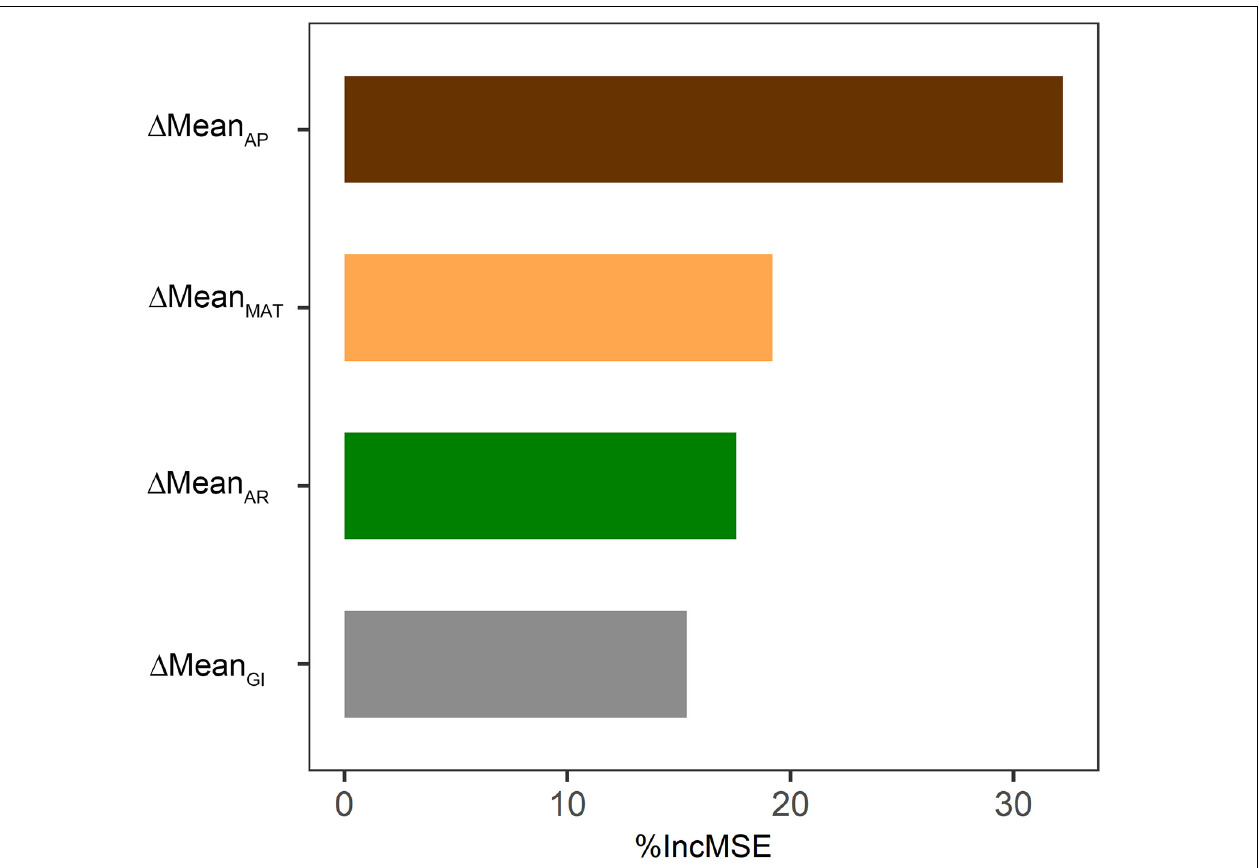
FIGURE 8 | Relative contribution of the differences in means of the four variables ( (cid:49) Mean MAT , (cid:49) Mean AP , (cid:49) Mean AR , and (cid:49) Mean GI ) to the differences in mean ANPP ( (cid:49) Mean ANPP ) between before and after starting the “ Ecological Security Barrier Protection and Construction Project ” in RF model. The values were denoted by the percentage increase of mean squared error (%IncMSE).